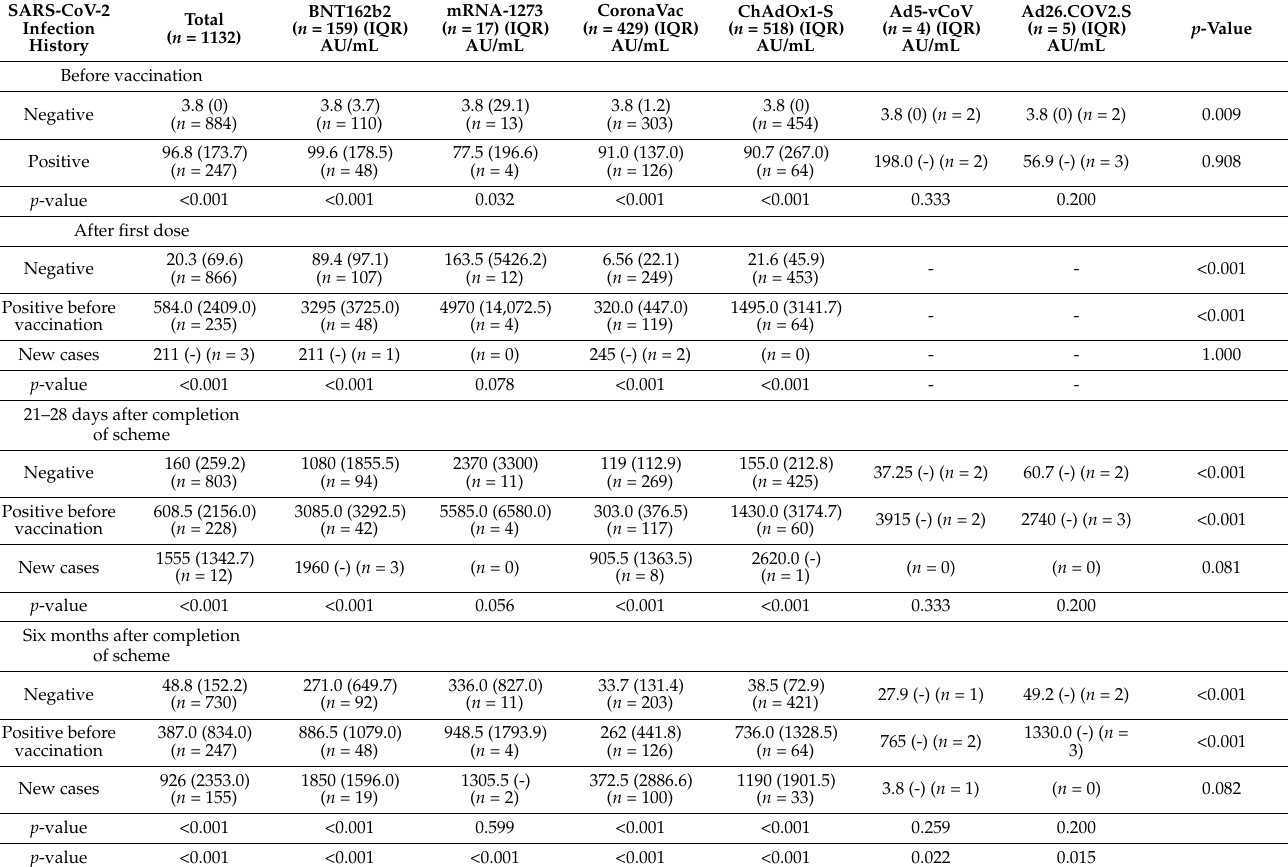
Table 2. Median IgG SARS-CoV-2 S1-S2 antibody titers by vaccine and SARS-CoV-2 infection